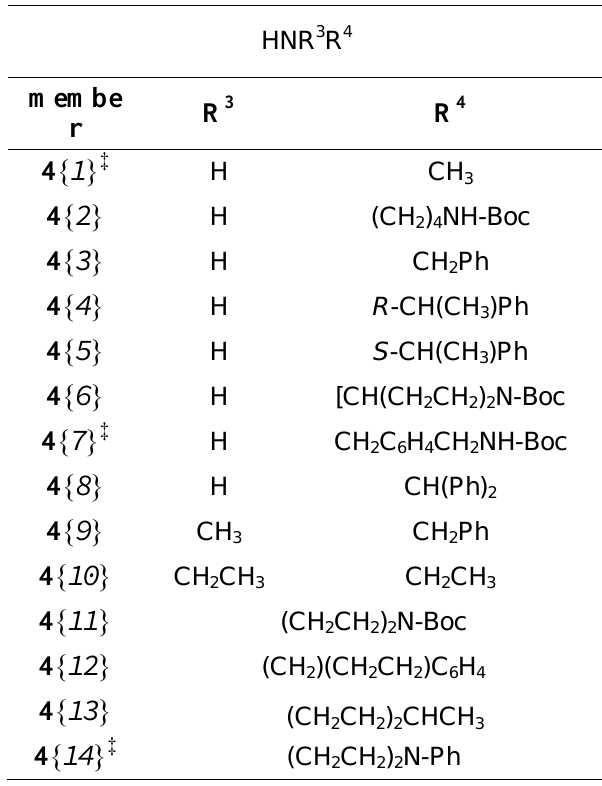
Table 2. Alkanamines, 4 { 1 - 14 }, used in library